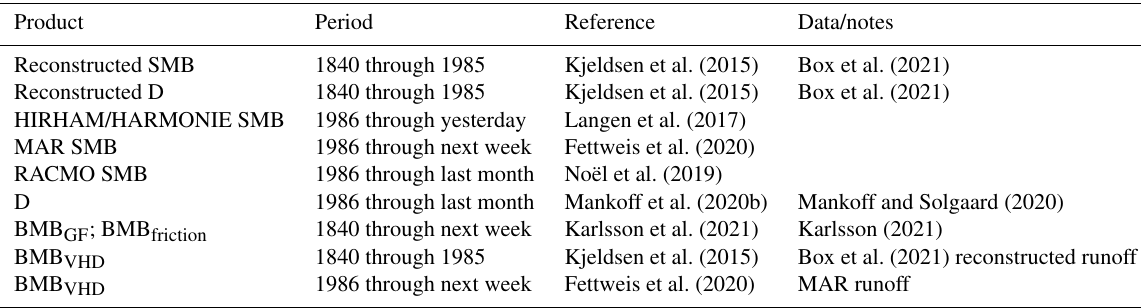
Table 1. Summary of data products used as inputs to This Study.